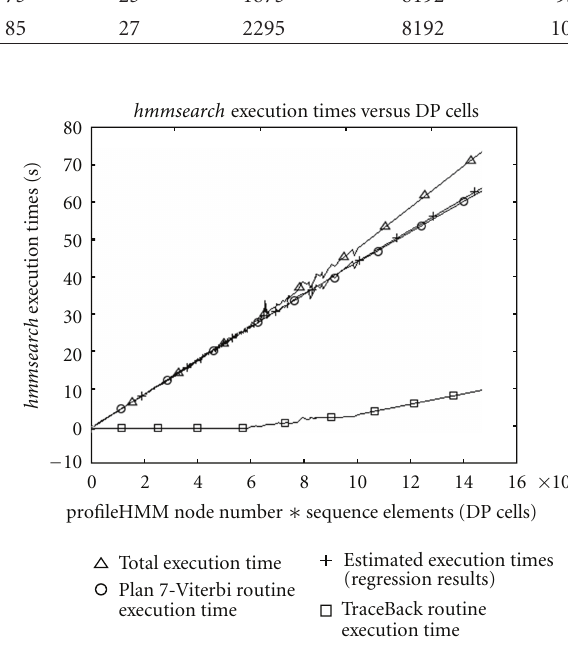
Figure 14: Unaccelerated hmmsearch performance for the test